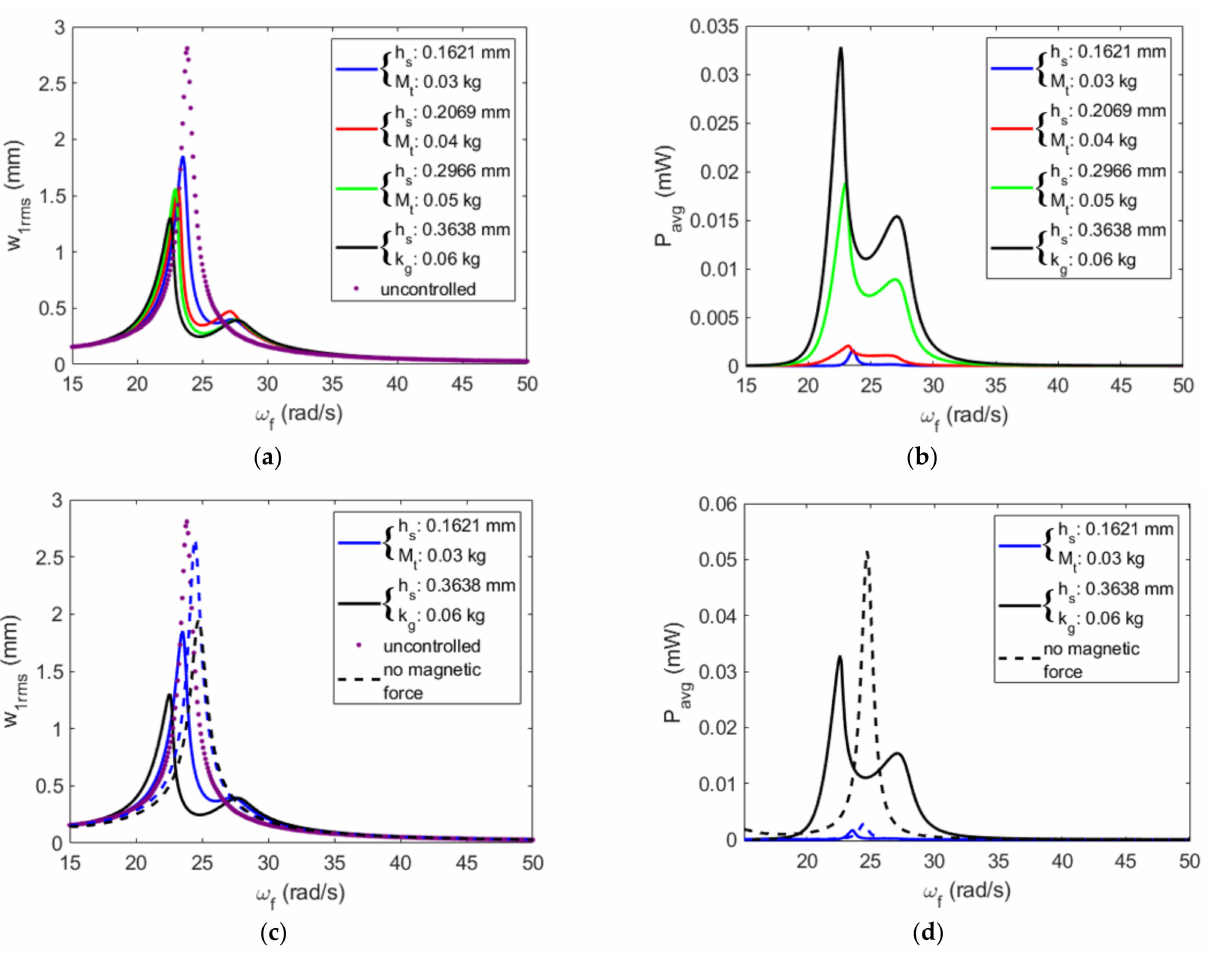
Figure 24. The effects of paired substrate thicknesses and tip masses that induce strong coupling and an initial gap of 7.5 mm on the amplitude of the ( a ) primary structure and ( b ) absorber, as well as a comparison with configurations with no magnets ( c , d